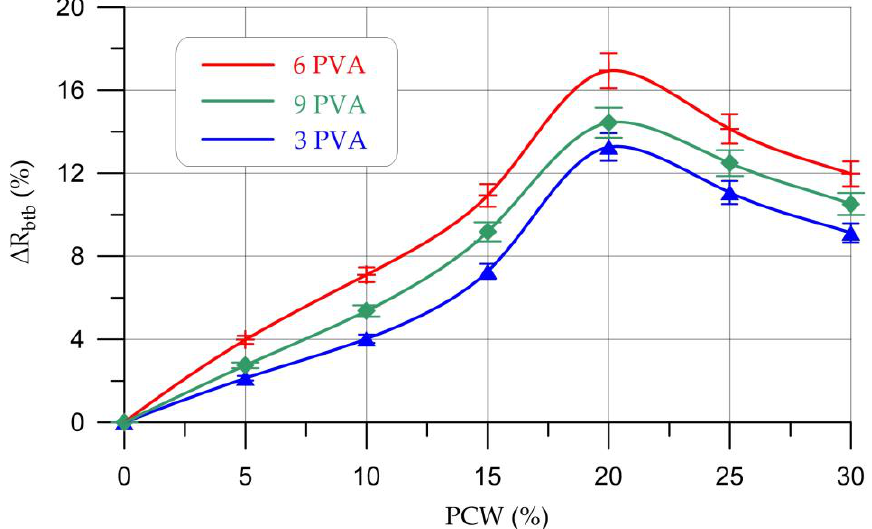
Figure 8. Change in bending strength (∆ R btb ) of geopolymer composites depending on the content of PCW and PVA. of PCW and